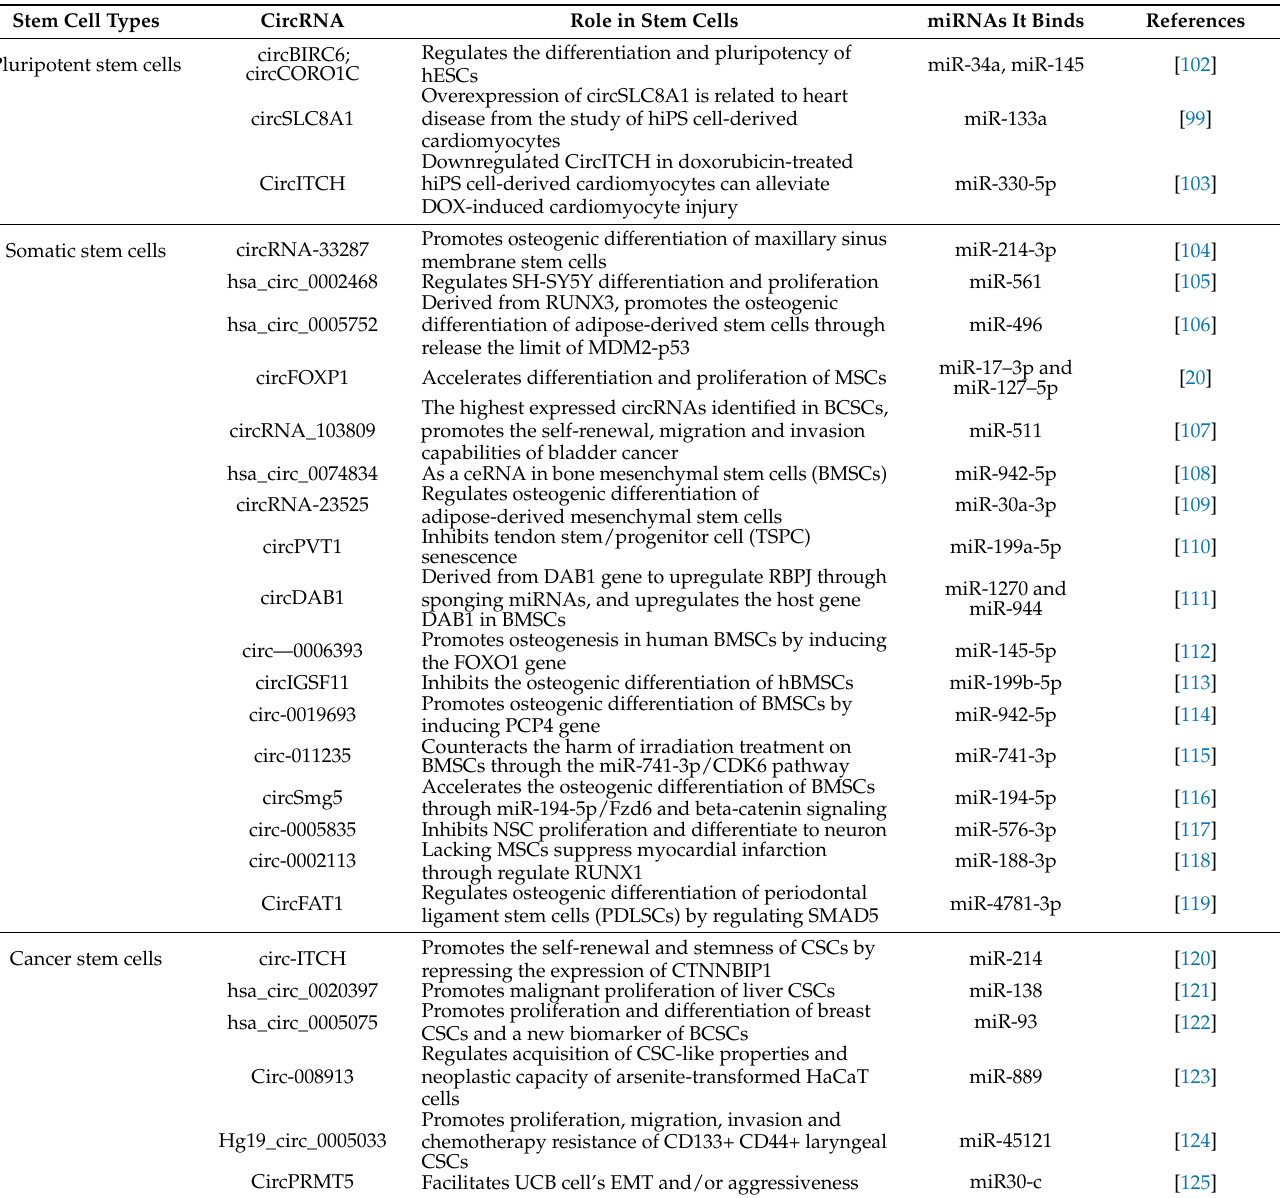
Table 2. Different circRNAs and their roles in multiple stem